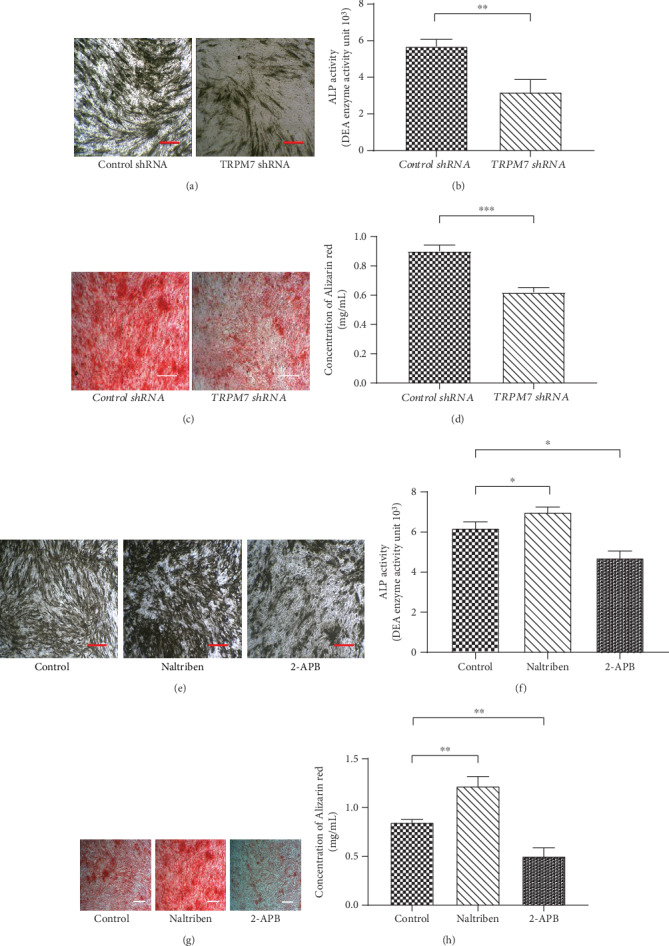
The effects of TRPM7 on the osteogenic differentiation in hBMSCs. (a) Analysis of ALP staining in cells treated with control shRNA and TRPM7 shRNA induced for 14 days. (b) Analysis of ALP activity (the unit for p-nitrophenyl: μmol) in cells treated with control shRNA and TRPM7 shRNA induced for 14 days. (c) Analysis of ARS staining in cells treated with control shRNA and TRPM7 shRNA induced for 14 days. (d) A quantification of ARS in cells treated with control shRNA and TRPM7 shRNA induced for 14 days. (e) Analysis of ALP staining in cells induced with osteogenic medium or osteogenic medium supplemented with Naltriben or 2-APB induced for 14 days. (f) Analysis of ALP activity (the unit for p-nitrophenyl: μmol) in cells induced with osteogenic medium or osteogenic medium supplemented with Naltriben or 2-APB induced for 14 days. (g) Analysis of ARS staining in cells induced with osteogenic medium or osteogenic medium supplemented with Naltriben or 2-APB induced for 14 days. (h) A quantification of ARS in cells induced with osteogenic medium or osteogenic medium supplemented with Naltriben or 2-APB induced for 14 days. Scale: 200 μm. ∗P < 0.05, ∗∗P < 0.01, and ∗∗∗P < 0.0001.